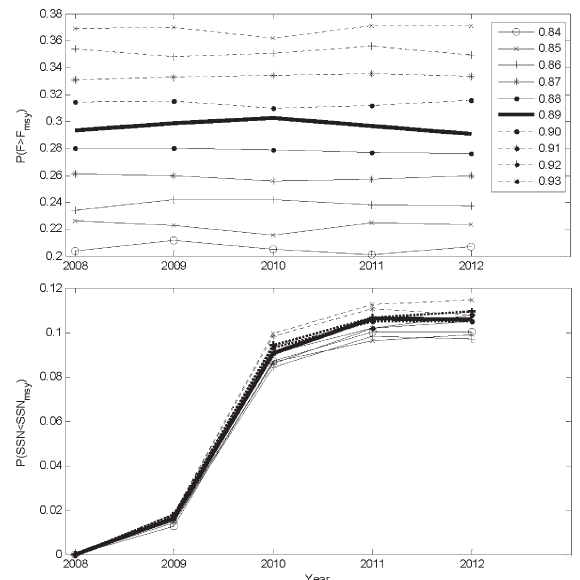
Fig . 6. – F as a fraction of F F ) and P ( SSN < SSN msy